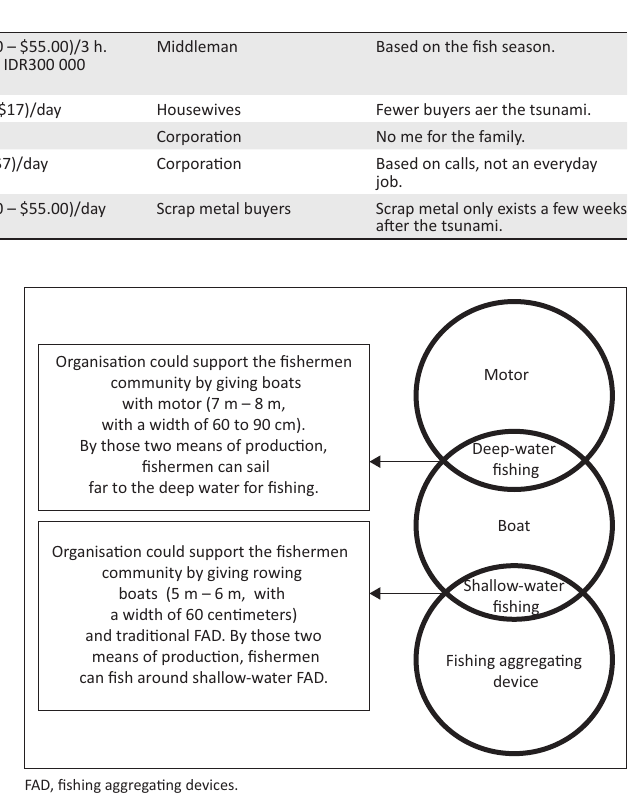
TABLE 2: Loli Dondo villagers’ livelihoods, income and problem analysis.